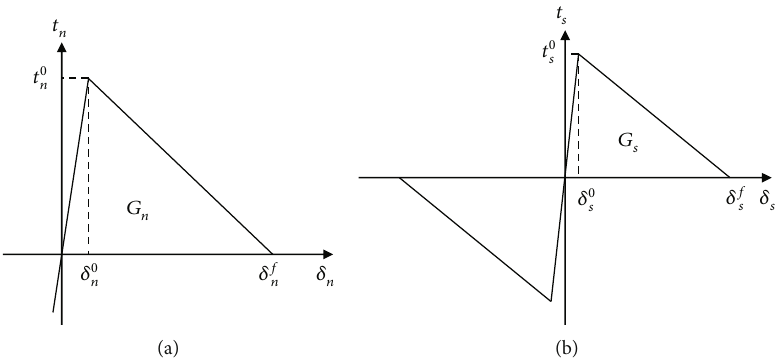
Figure 2: Bilinear traction-separation constitutive law for (a) tensile and (b) shear failure of the cohesive element. Pore pressure node